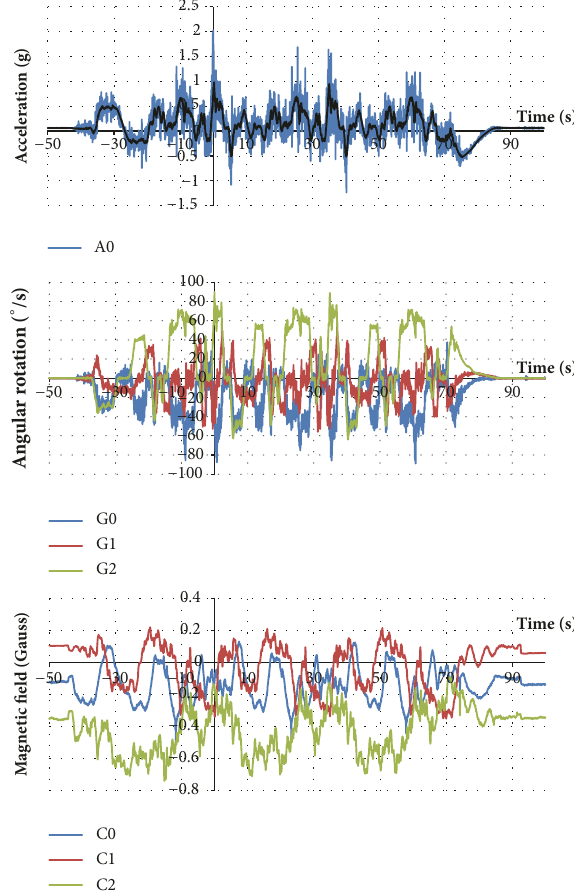
Figure 19: Illustration of the variation of the different sensor values during a typical session, grouped by acceleration (accelerometer), angular rotation (gyroscope), and magnetic field (compass). For legibility, only one accelerometer out of three is 2 3 Figure 18: Touch-screen reported ease of use while interacting during turbulence.